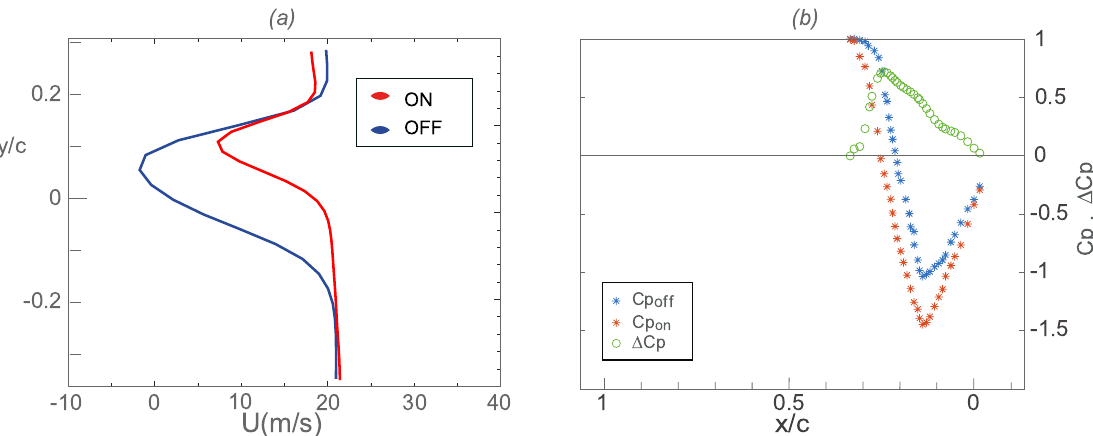
Figure 9. ( a ) Cross-wake velocity profile and ( b ) C P values at T A for α = 14.5 ◦ and U ∞ = 20